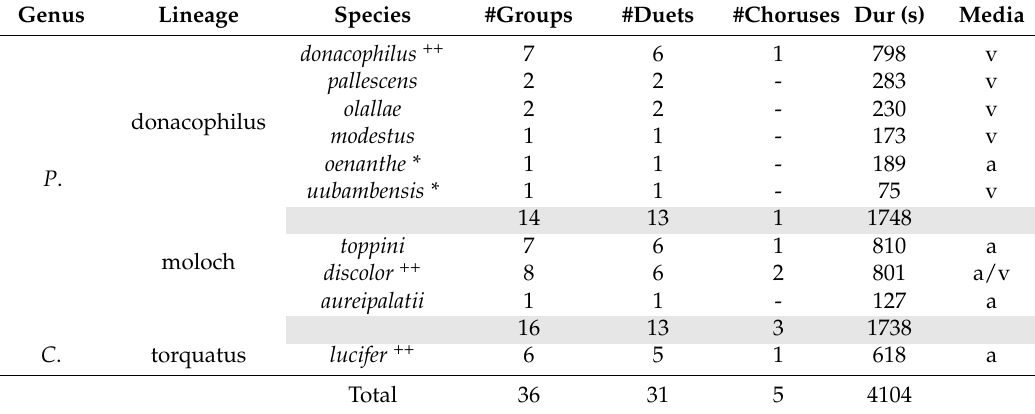
Table 3. The ten species of titi monkeys from which duets and choruses were analyzed. For each species, the number of analyzed duets and choruses are reported together with the total duration of the recordings and the media that was used (v = video, a = audio). Gray areas highlight total numbers separately for the donacophilus and moloch lineages. P . = Plecturocebus ; C . = Cheracebus . Species for which genetic studies exist [62,64,65] are designated by the superscript ++. Hyphen signifies “no data”. Genus Lineage Species #Groups #Duets #Choruses Dur (s) Media donacophilus donacophilus P .